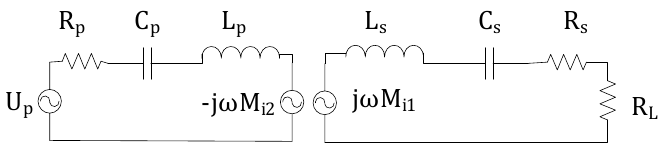
Figure 1. The circuit model of the inductive coupled wireless charging system with two series compensation. The high-frequency inverter AC power supply RMS voltage is U p , R L is pure impedance load, L p and L s are self-inductance of the power supply side coil and the load side coil, respectively, and M is mutual inductance. The two coils have internal impedance, and R p is the sum of the impedance of the power supply side coil and the primary side cable, R s is the sum of the load side coil impedance and the load side cable impedance. C p and C s are the power supply side and the load side resonant compensation capacitance, respectively. The current of the primary side and the secondary side are I p and I s